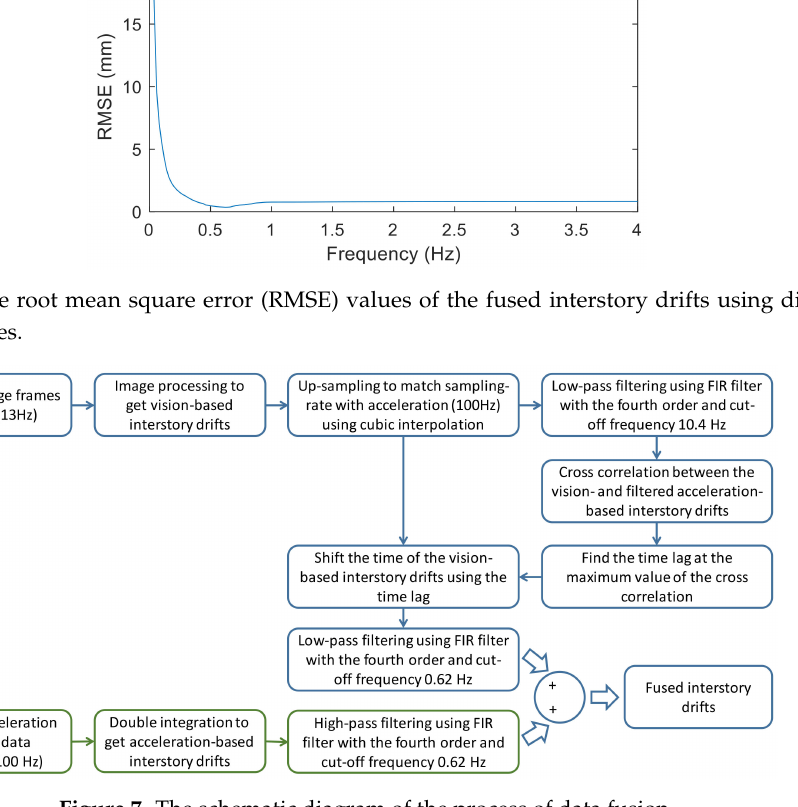
Figure 7. The schematic diagram of the process of data